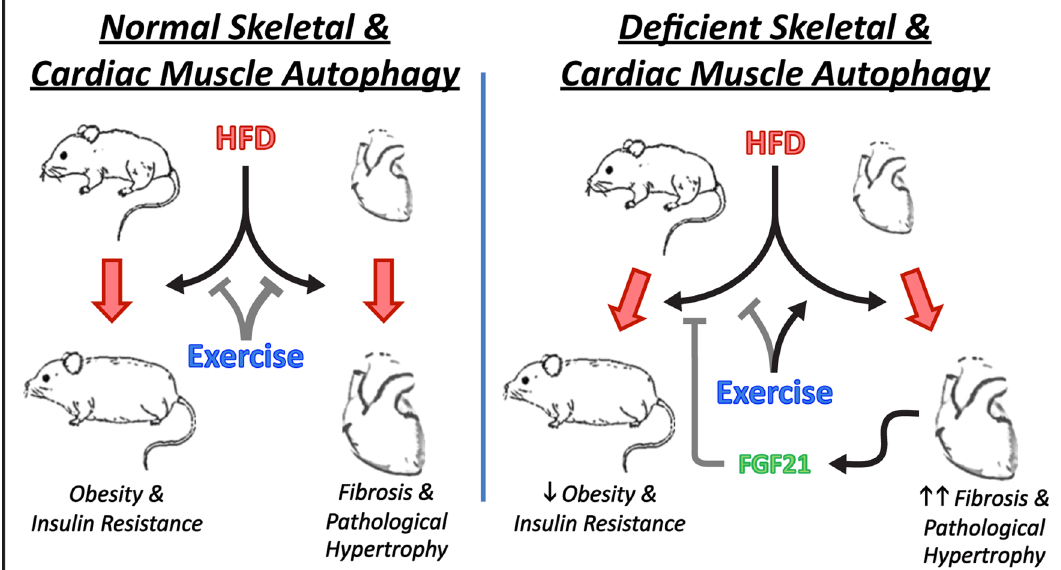
Figure 7. Autophagy is essential for the beneficial cardiac remodelling caused by exercise training in obesity and insulin resistance. Exercise training ameliorates diet-induced obesity and insulin resistance, and is very effective in preventing cardiac fibrosis and pathological hypertrophy when cardiac and skeletal autophagy is normal. Conversely, deficient skeletal and cardiac muscle autophagy dissociates the whole-body metabolic benefits of exercise (e.g., protection against obesity and insulin resistance) from cardioprotection. This phenomenon is driven primarily by the exercise training-mediated impairment of mitochondrial protein homeostasis, as well as exacerbation of ER stress, fibrosis and pathological hypertrophy in the hearts of mice with deficient autophagy. This unfavourable cardiac remodelling, however, potentiates the metabolic benefits of exercise in the periphery, at least in part, by elevating circulating FGF21 levels. Arrows represent stimulation, whereas T-shaped connectors represent inhibition. Thicker lines indicate stronger observed